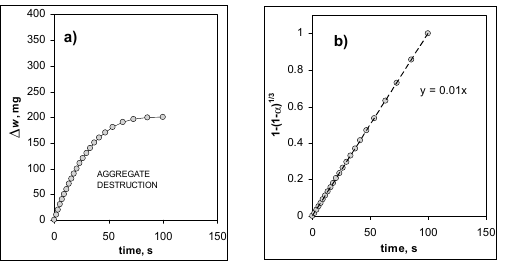
Figure 1. ( a ) Simulated aggregate destruction curve for k = 0.01 s − 1 ( t d = 100 s) and ∆ w = 200 mg. ( b ) The destruction curve plot in coordinates of Equation (4) (slope = k).